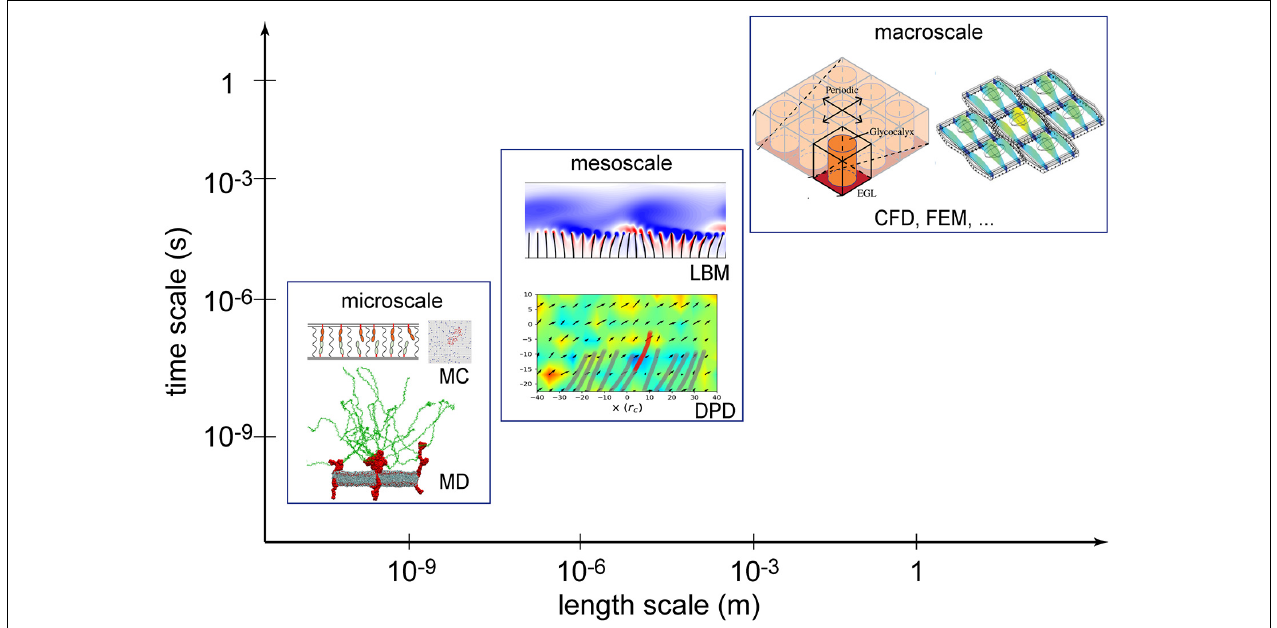
FIGURE 1 | Numerical methods used in the investigation of the endothelial glycocalyx (EG) mechanotransduction. Computational fluid dynamics (CFD) and the finite element method (FEM) are two established macroscopic methods; lattice Boltzmann method (LBM) and dissipative particle dynamics (DPD) are typical mesoscopic methods; molecular dynamics (MD) and Monte Carlo (MC) are deterministic and stochastic microscopic methods, respectively. Sources: MC is from Xu et al. (2016), MD from Jiang et al. (2017), LBM from O’connor and Revell (2019), DPD from Jiang et al. (2021), CFD from Lee et al. (2020), and FEM from Dabagh et al. (2014). Reuse of figures are permitted by the Cambridge University Press, Royal Society of Chemistry and the Royal Society (United